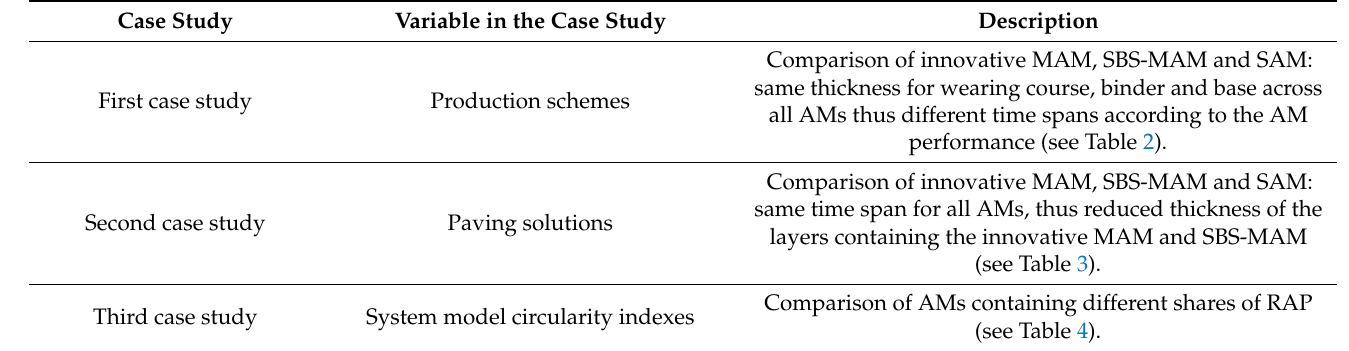
Table 1. Summary of the three case studies analyzed.